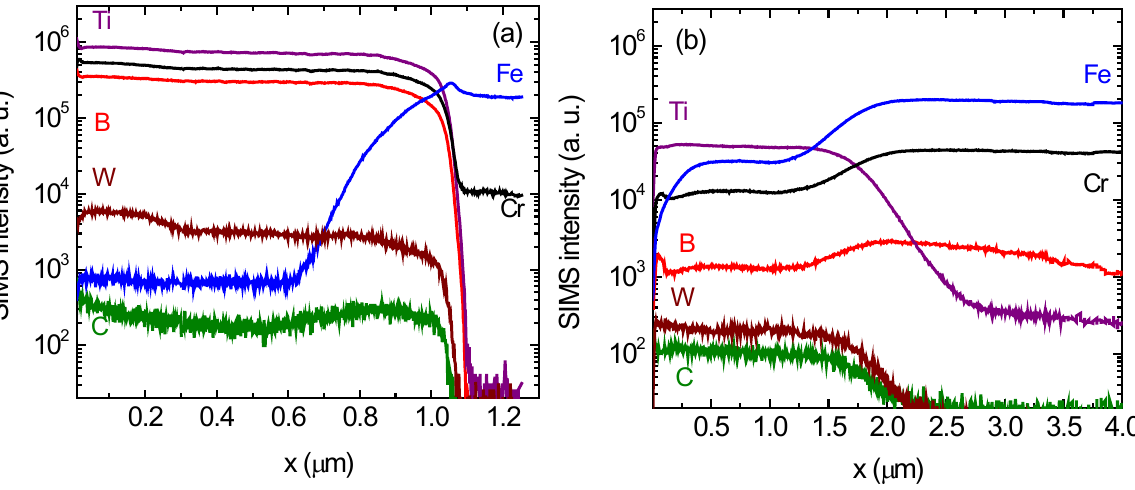
Figure 4. Secondary ion mass spectrometry depth profiles of (Ti ( a ) the as-deposited state and ( b ) after annealing for 1 h at 1100